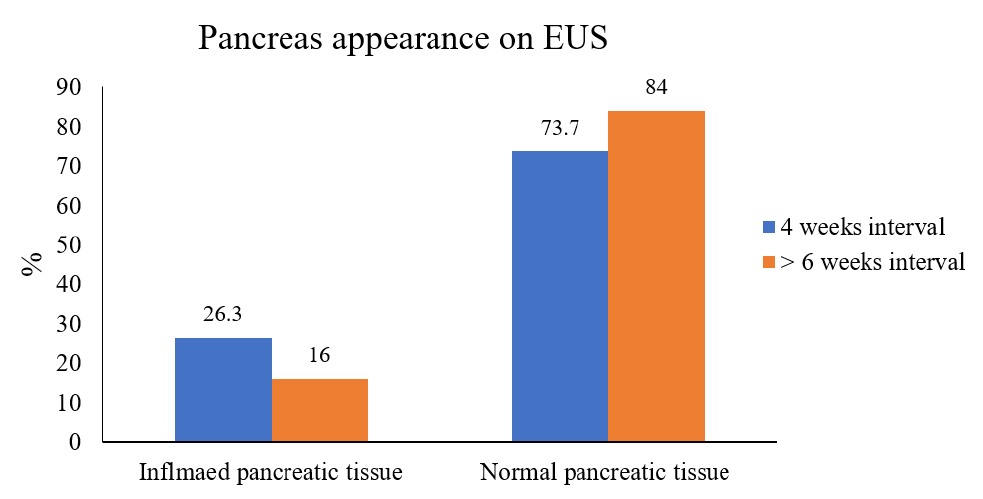
Figure 4. EUS pancreatic tissue appearance according to time interval.